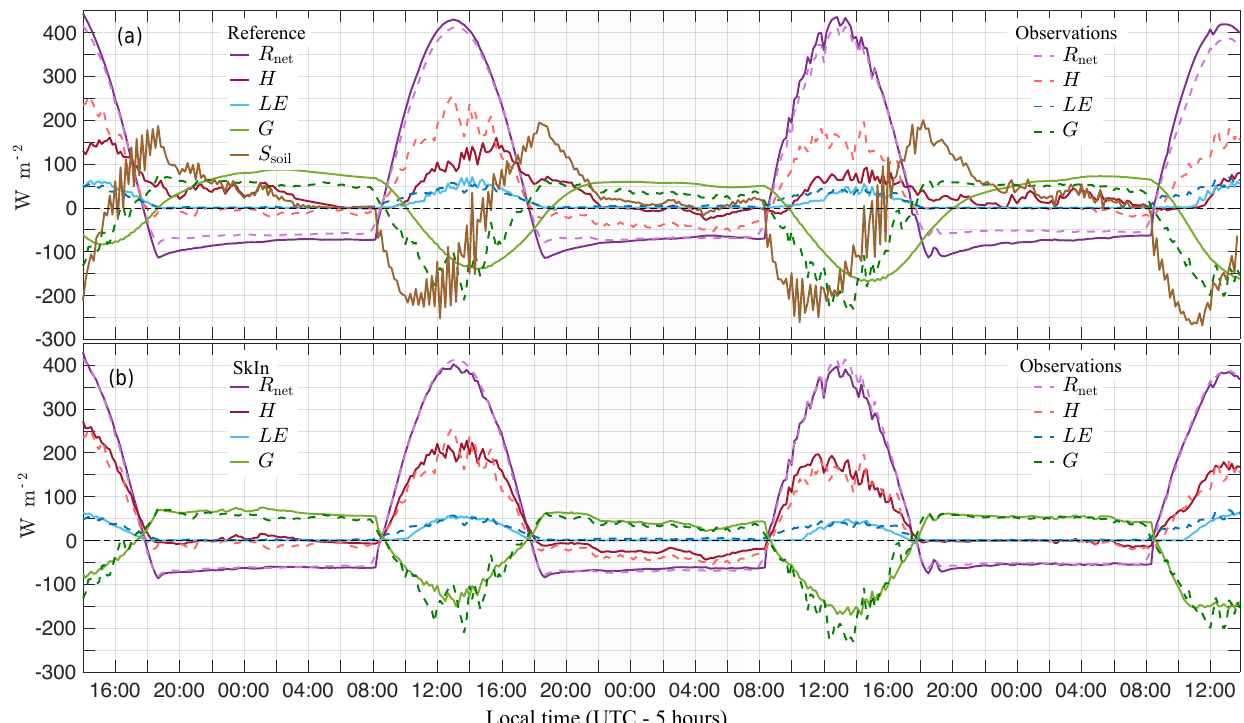
Figure 2. Performance of the JSBACH scheme on diurnal timescales: comparison of the time series of the components of the surface energy balance equation between the reference model (a) and the observations, and SkIn (b) and the observations (dashed lines). Plotted are the net radiation ( R net , violet), sensible heat flux ( H , red), latent heat flux (LE, blue), ground heat flux ( G , green), and heat storage term ( S soil , brown). Data are from the CASES-99 experiment in Kansas from 23 to 26 October